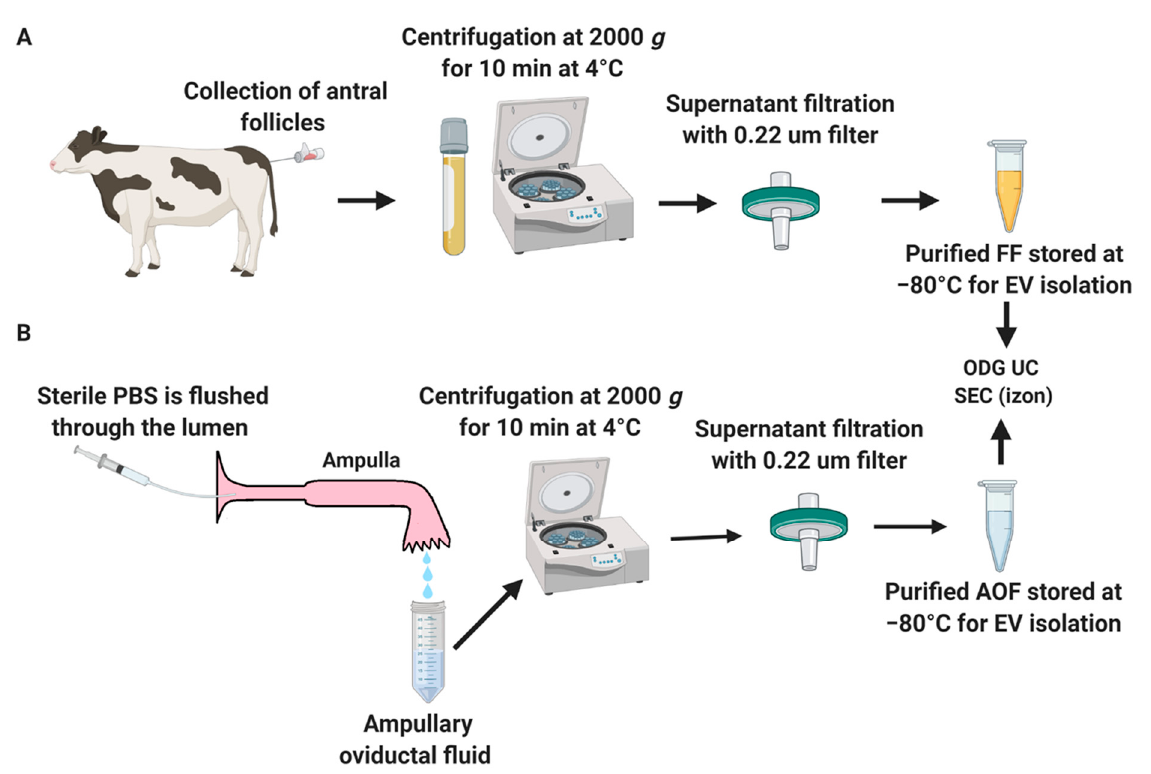
Figure 3. Schematic representation of follicular fluid (FF) ( A ) and ampullary oviductal fluid (AOF) ( B ) collection. Follicular fluid was isolated from estrous Holstein heifers with antral follicle sizes larger than 12 mm. Ampullary fluid was flushed from the oviduct at the early postovulatory phase of the estrous cycle. Both FF and AOF fluids were subjected to EVs isolation methods OptiPrep™ density gradient ultracentrifugation (ODG UC) and single-step size exclusion chromatography (SEC) (qEV IZON™ single column). PBS: phosphate-buffered saline.